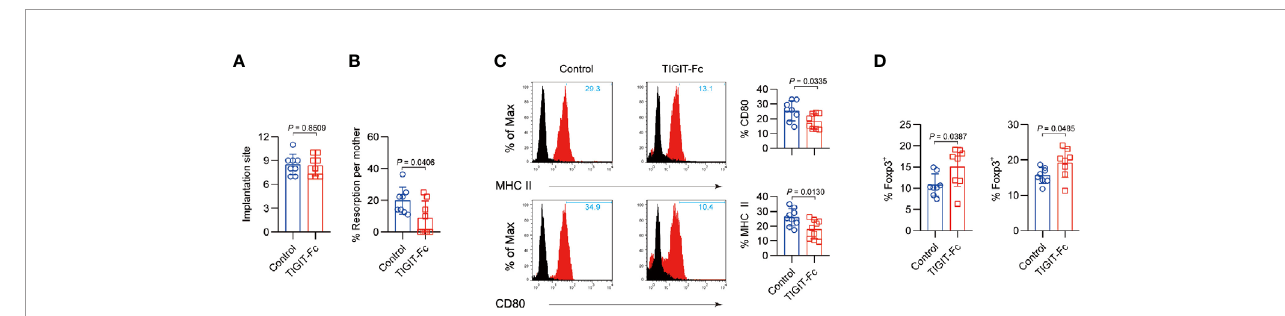
FIGURE 5 | Administration of TIGIT-Fc protects fetuses from abortion. Treatment with mTIGIT-Fc of pregnant CBA/J females mated with DBA/2J males at 1.5 and 3.5 dpc. (A) , the total number of implantation sites and (B) , Resorption rates were measured at 12.5 dpc in the mated female mice, n = 8. (C) Phenotypic analysis of CD11c + uterine DCs from mice treated with control IgG (Control) or TIGIT-Fc at 6.5 dpc. The percentages of MHC-II- and CD80-positive cells are plotted as bar graphs (right panels), n = 8. (D) Percentages of CD4 + Foxp3 + T cells in the uterus (left) and PALNs (right) of different groups were calculated by fl ow cytometry analysis at 6.5 dpc. n = 8. Data are the means ± s.d (A – D) and all the P values were from a one-way ANOVA followed by Tukey post-test (A – D)